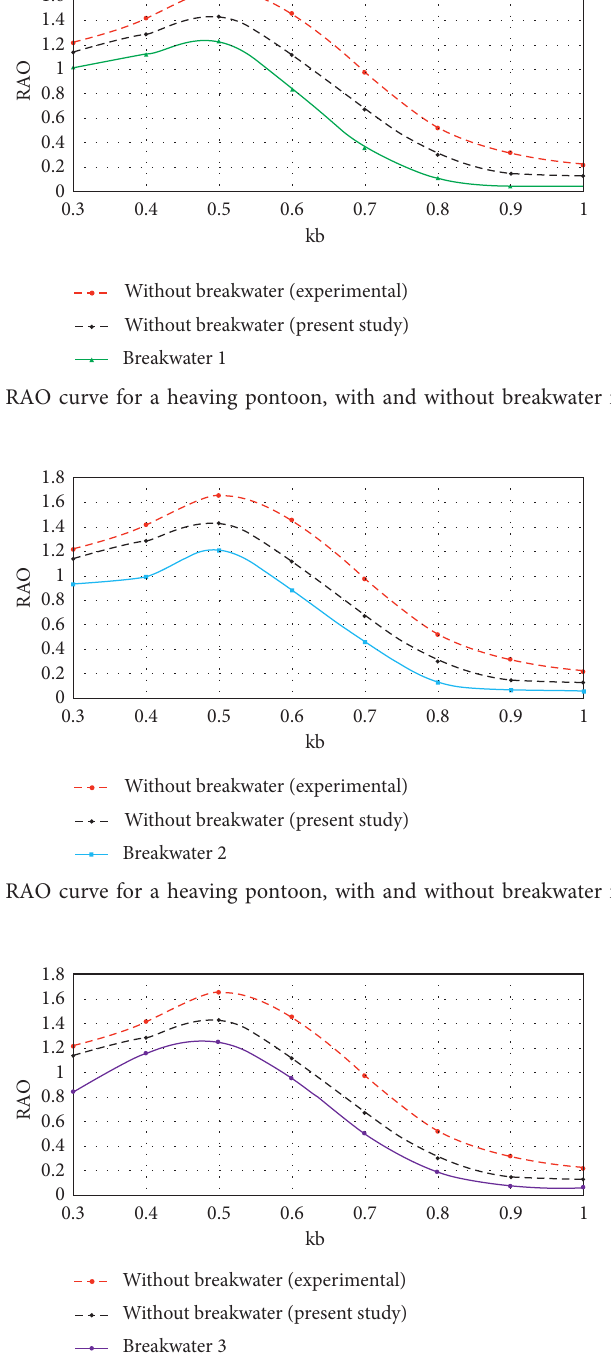
Figure 15: RAO curve for a heaving pontoon, with and without breakwater number